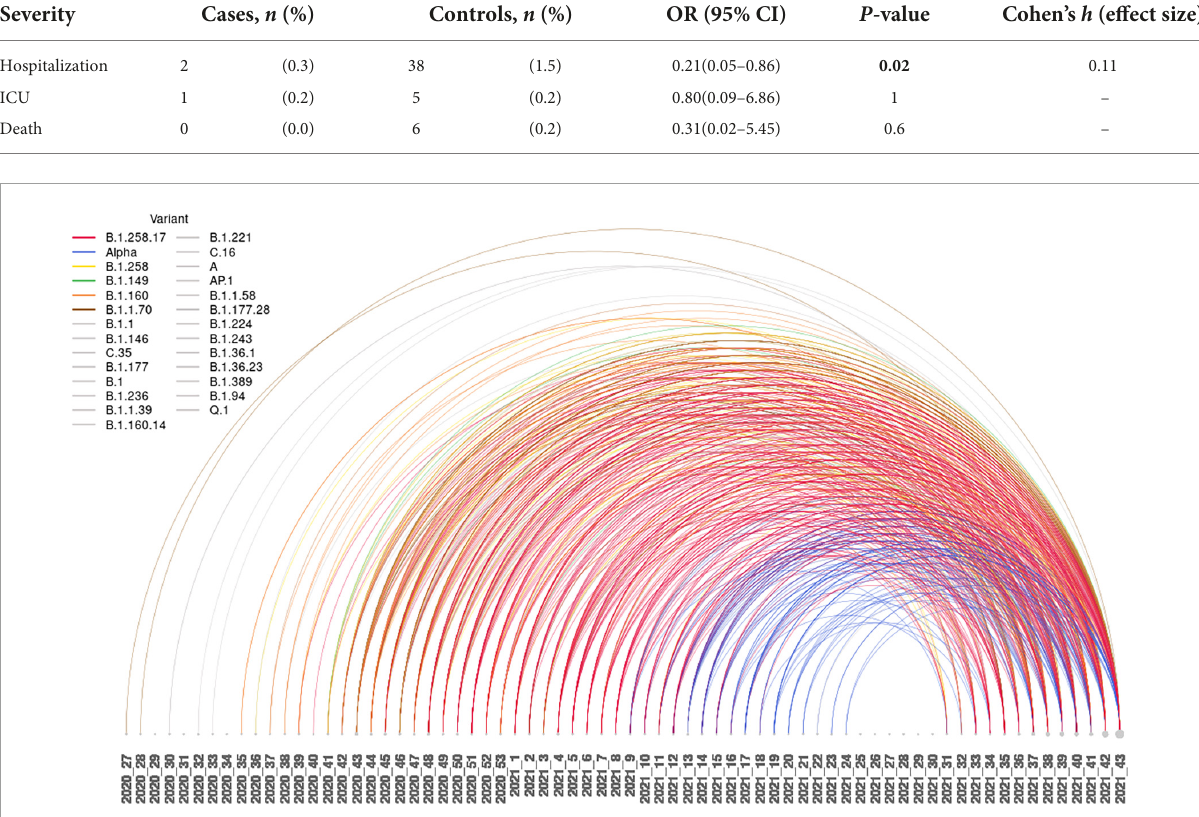
FIGURE2 Arc plot of reinfection intervals between the first and second SARS-CoV-2 episodes. The lines are color coded for the six most represented